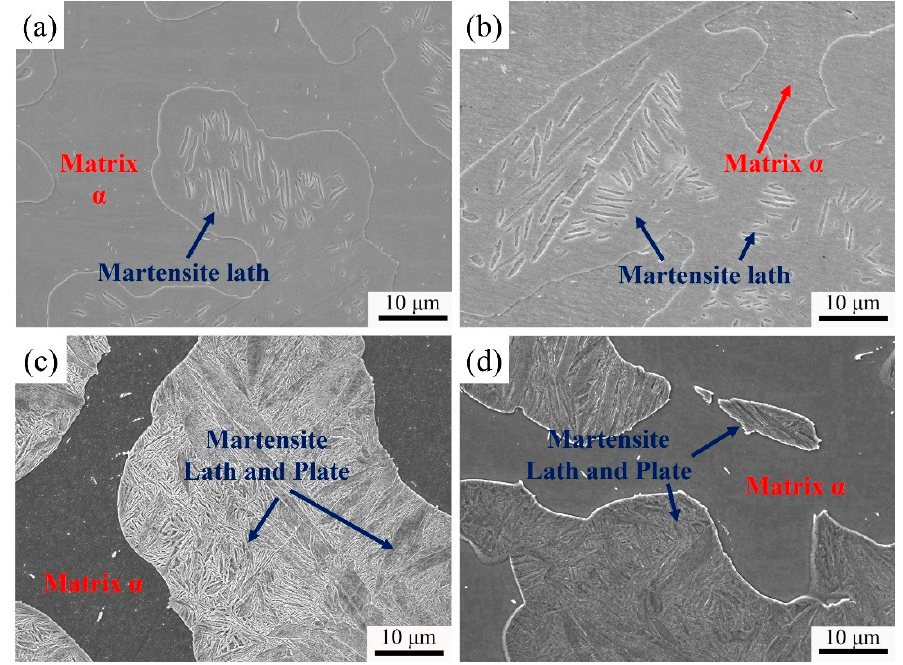
Figure 1. SEM image of the experimental steel solution treatment at different temperatures: ( a ) 900 °C; ( b ) 1000 °C; ( c ) 1100 °C; ( d ) 1200 °C.